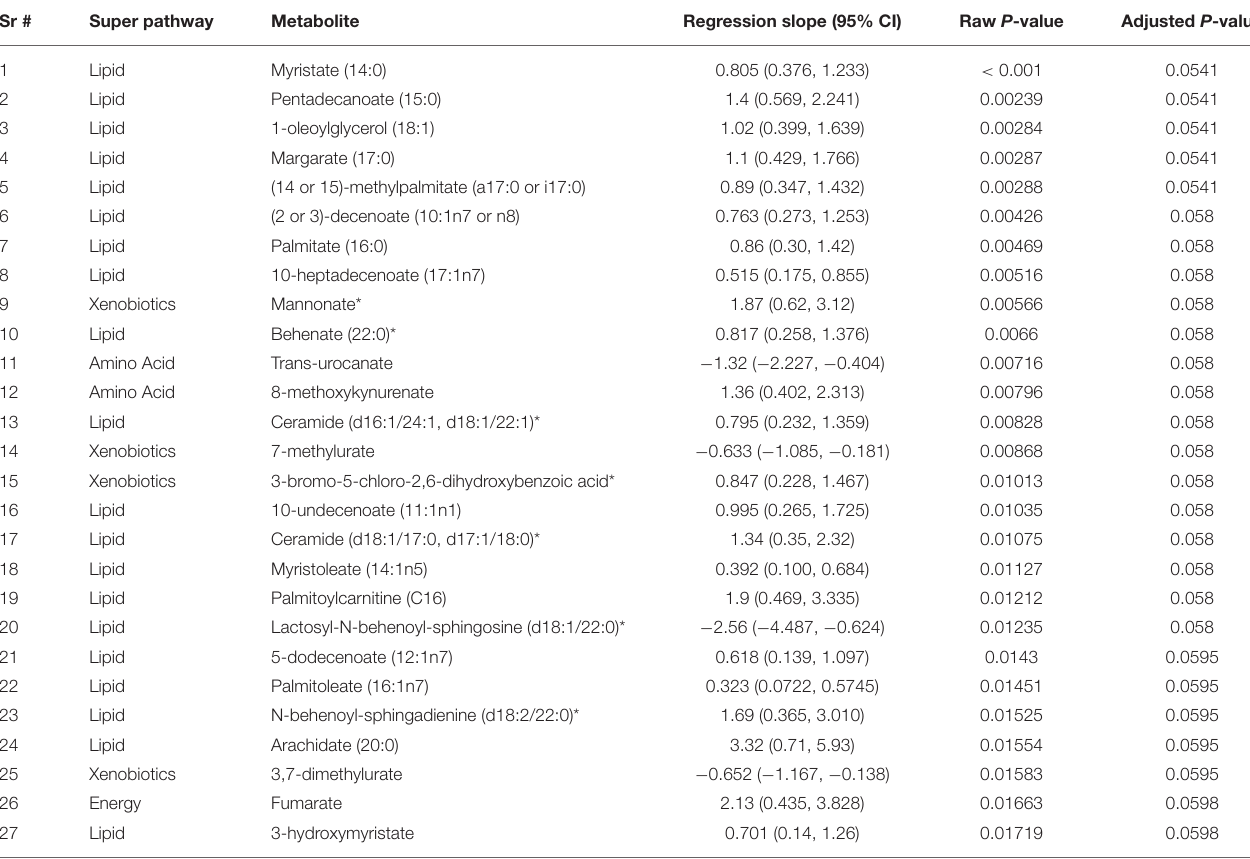
TABLE 2 | Metabolite expression correlated with progression of